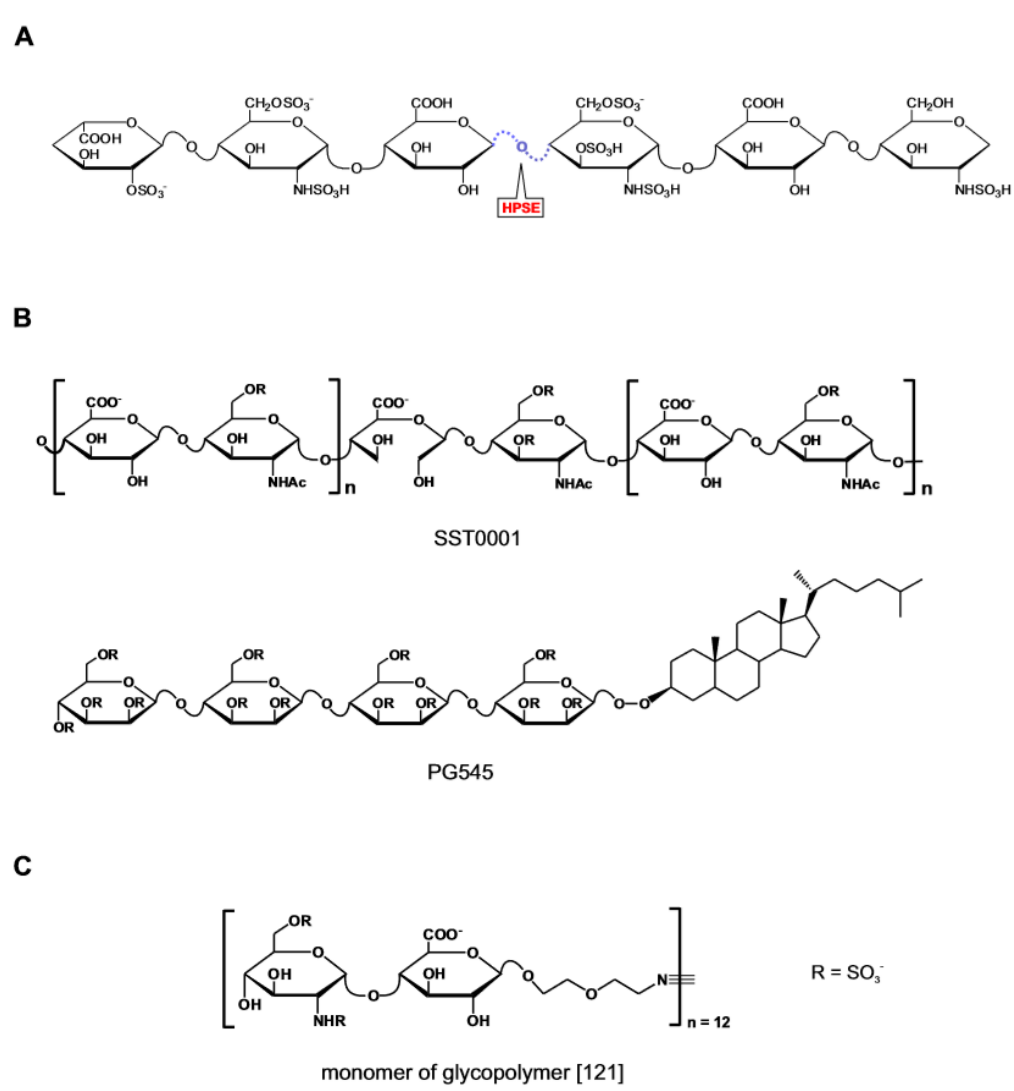
Figure 7. Heparanase inhibitors. ( A ) Schematic representation of the catalytic activity of heparanase acting on heparin / HS. ( B ) Heparanase inhibitors currently in clinical trial. ( C ) Monomeric unit of fully synthetic polymeric inhibitor. Structure redrawn from ref [121].